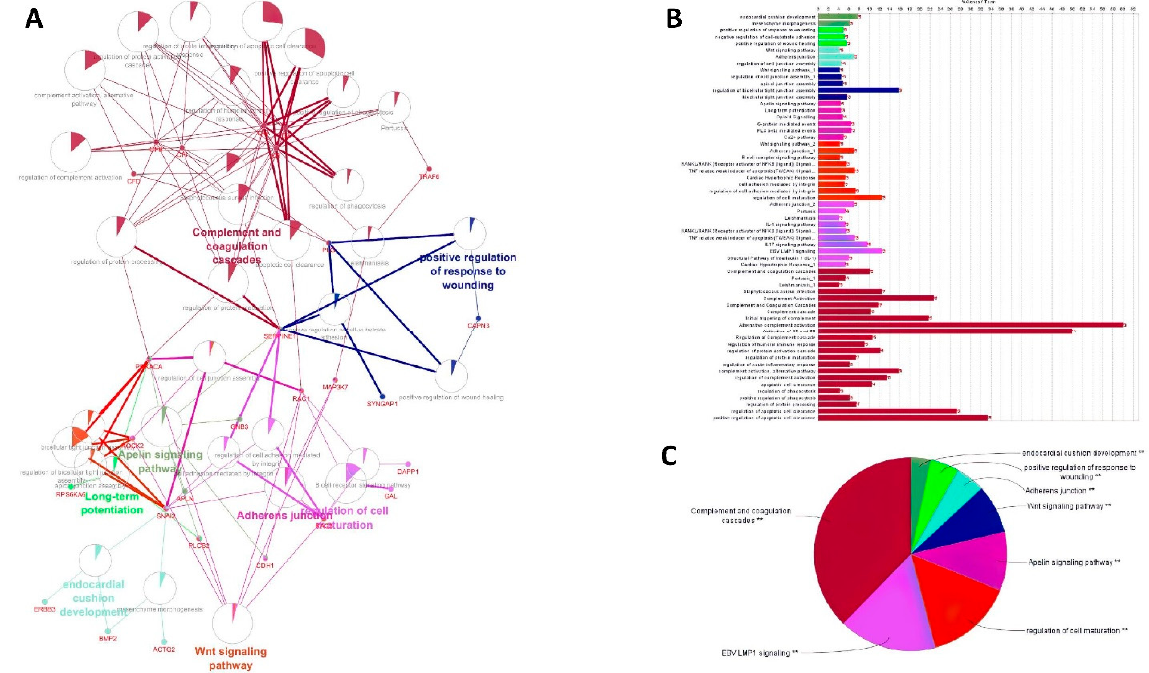
Figure 3. ( A ) Gene Ontology was constructed by integrating KEGG, Reactions, and WikiPathways. Each node illustrates a pathway or term and the percentage of visible shared genes between pathways or terms and edges present relationships between pathways; ( B ) bar chart shows the number of genes and related pathways using ClueGO and CluePrdia software based on different databases ( C ) pie chart shows the number of genes and related pathways using ClueGO and CluePrdia software based on different databases. ** represents hub genes were significantly enriched in these biological processes and molecular functions.